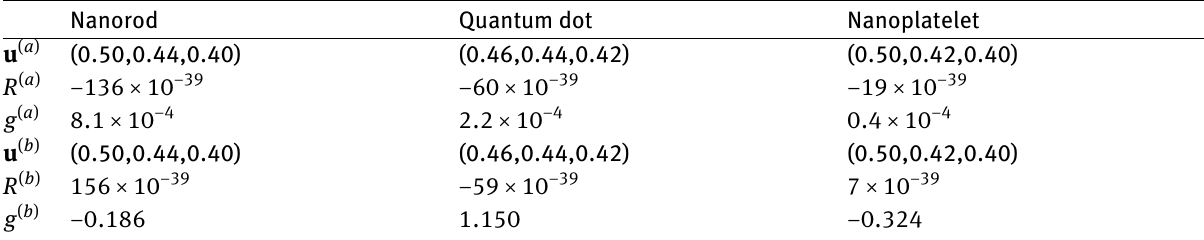
Figure 3: CD spectra of (a) 2×3×9 nm 3 nanorod, (b) 3.4×3.8×4.2 nm 3 quantum dot, and (c) 1.5×5×6 nm 3 nanoplatelet with different positions of an impurity shown by the color dots in the insets. The insets represent cross sections of the nanocrystals at x = l x /4 . All the spectral lines are approximated by Lorentzians with a FWHM of 0.1 eV [27]. The material parameters are the same as in Fig. 2. Table 1: Rotatory strengths (in the units of erg × cm 3 ) and dissymmetry factors of (a) electric dipole transition (111) → (121) and (b) mag- netic dipole transition (111) → (122) inside nanorod, quantum dot, and nanoplatelet with a single impurity located at optimal position u , which corresponds to the maximum of rotatory strength. All material parameters are the same as in Fig.